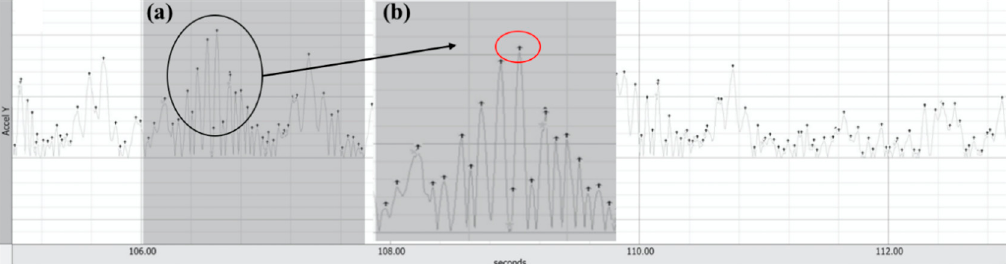
Figure 2. Body centre of mass acceleration signal (Y–axis). The signal shows all the changes in the body centre of mass acceleration (BCMA) during one repetition (entire phase) of the half-squat performed on the floor ( a ) = The shaded area shows the total number of amplitudes in the entire phase; ( b ) the magnified zone details each of the maximum BCMA values (red circle). These values were summed to determine the value of BCMA in the entire phase.